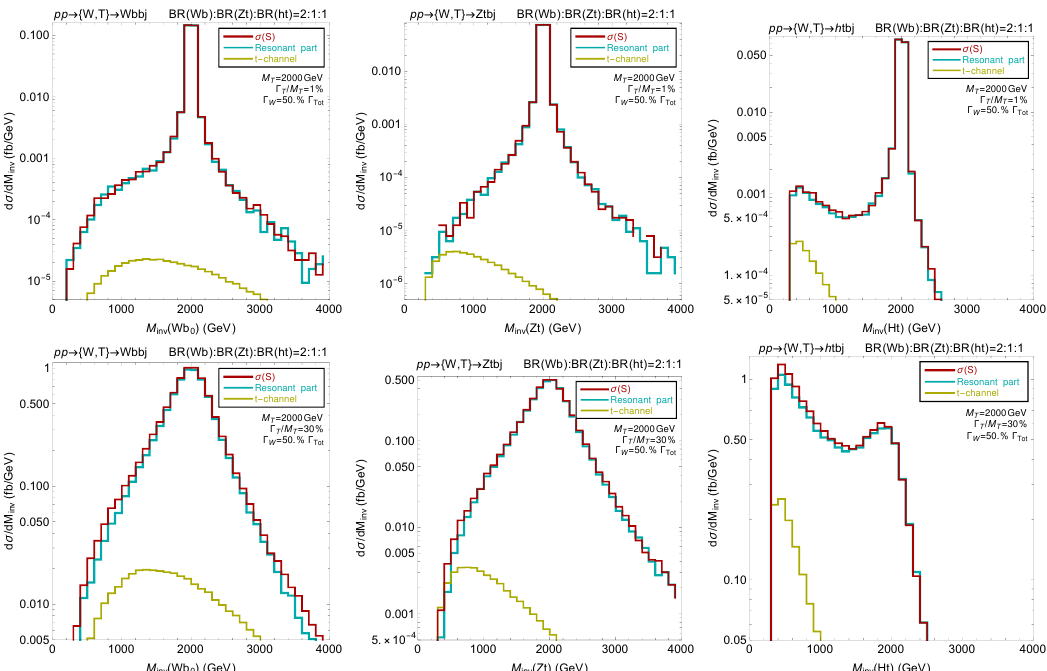
Figure 17 . Same as figure 3 for M T = 2